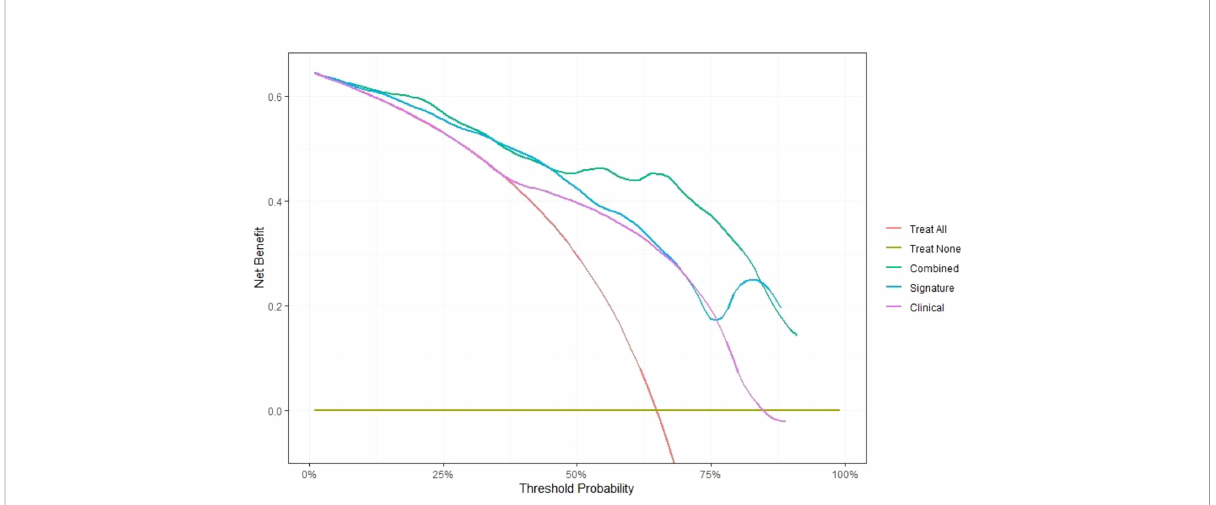
FIGURE 7 Comparison of the net bene fi ts of the combined prediction model (green), delta radiomics prediction model (blue) and clinical prediction model (purple) using decision curve